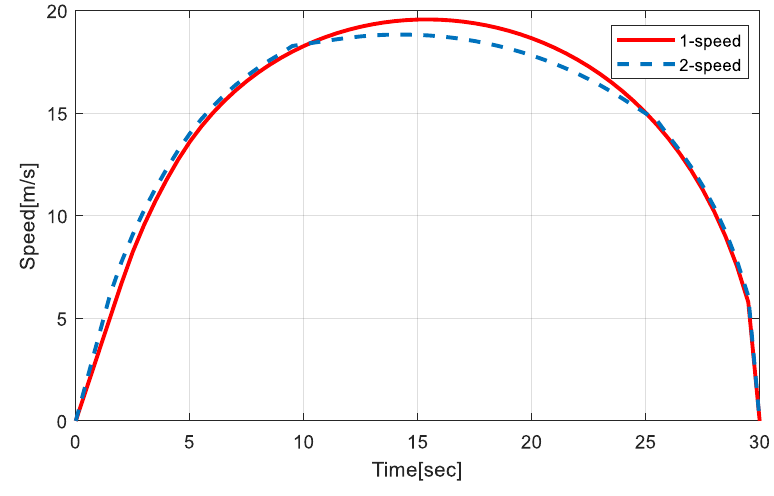
Figure 7. Comparison of speed trajectories under different gearboxes.